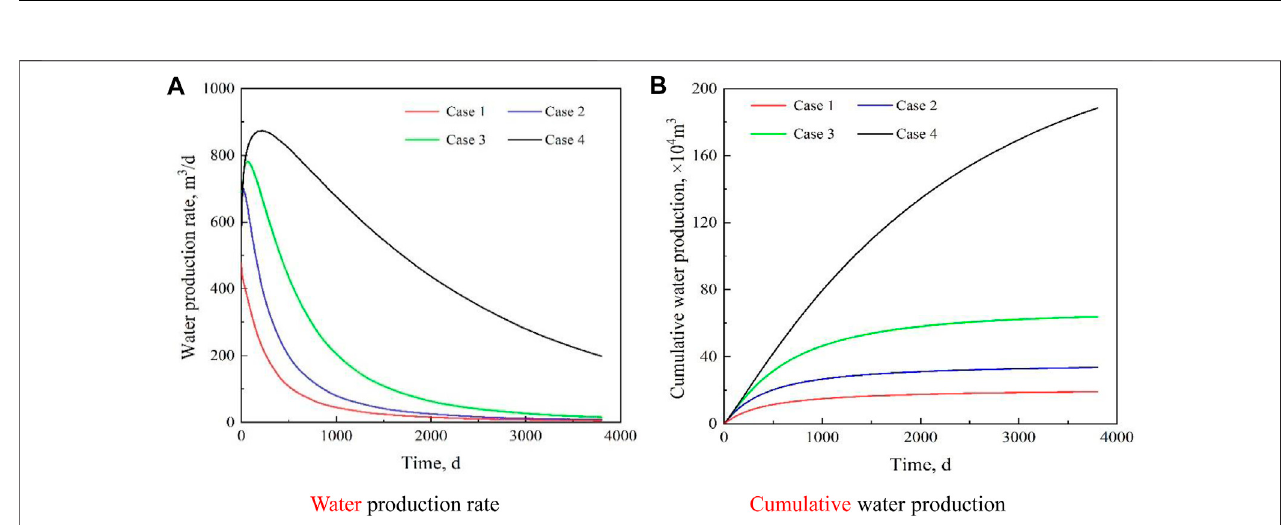
FIGURE 5 | In fl uence of aquifer on gas production. (A) Gas production rate. (B) Cumulative gas production.